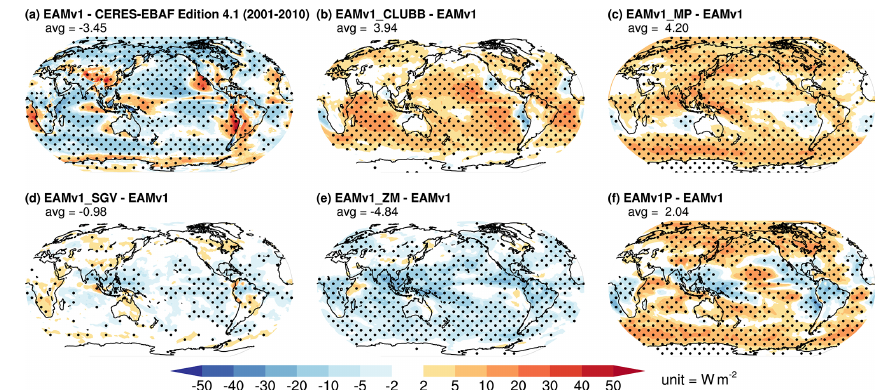
Figure 4. Difference in present-day TOA SWCRE (Wm − 2 ) climatology between (a) EAMv1 and Clouds and Earth’s Radiant Energy System (CERES) (Wielicki et al., 1996) Energy Balance and Filled (EBAF) Edition 4.1 (Loeb et al., 2012, 2003, 2018) averaged over 2001–2010, (b) EAMv1_CLUBB and EAMv1, (c) EAMv1_MP and EAMv1, (d) EAMv1_SGV and EAMv1, (e) EAMv1_ZM and EAMv1, and (f) EAMv1P and EAMv1. Model TOA SWCRE values are 10-year averages. Stippling denotes significant difference at the 95% confidence level based on a Student’s t test.